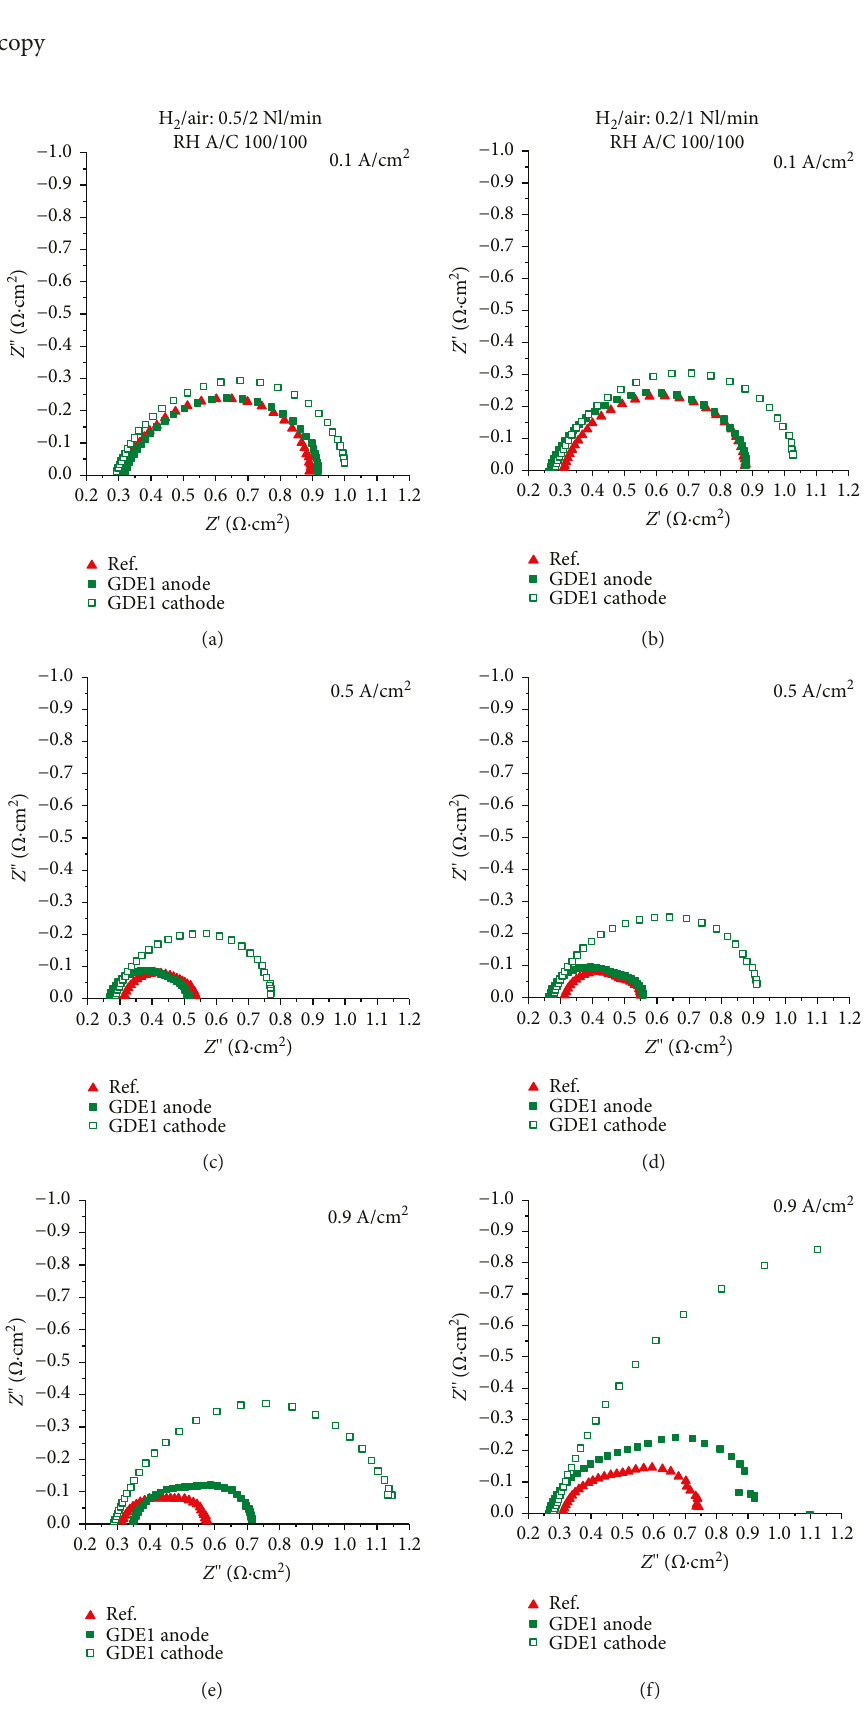
Figure 5: Example of impedance spectra acquired at di ff erent current densities (i.e., from 0.1A/cm 2 to 0.9A/cm 2 ) at high (a, c, e) and low (b, d, f) inlet gas fl ow rate for the reference sample, GDE1 anode, and GDE1